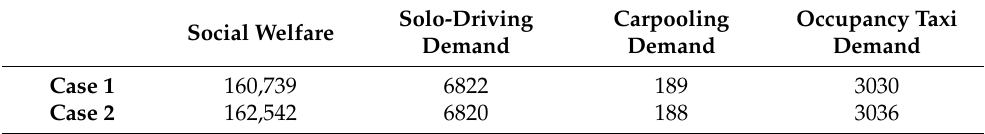
Table 4. The social welfare of case 1 and case 2 in the Sioux Falls